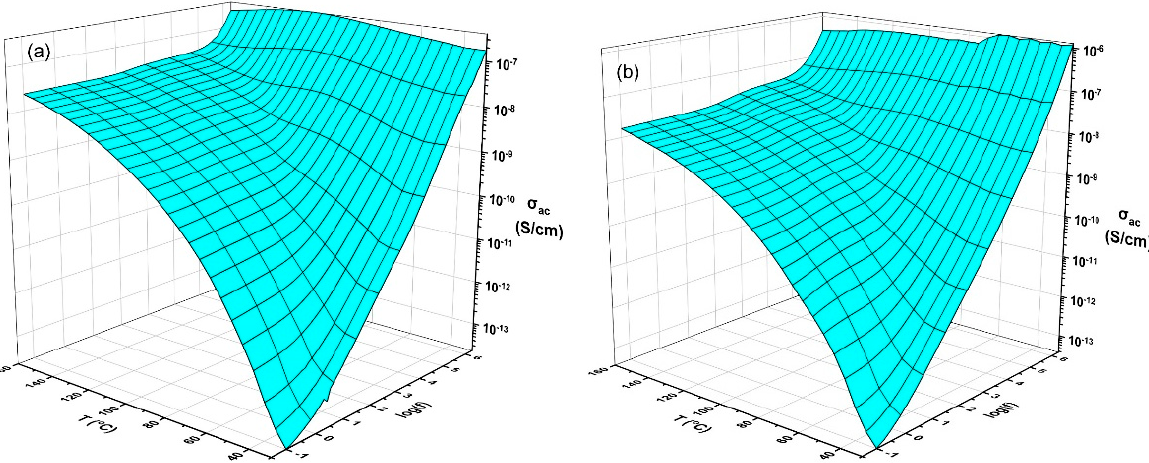
Figure 6. ac conductivity as function of frequency and temperature for: ( a ) unfilled epoxy and ( b ) 5 phr TiC/5 phr BN/epoxy nanocomposite.